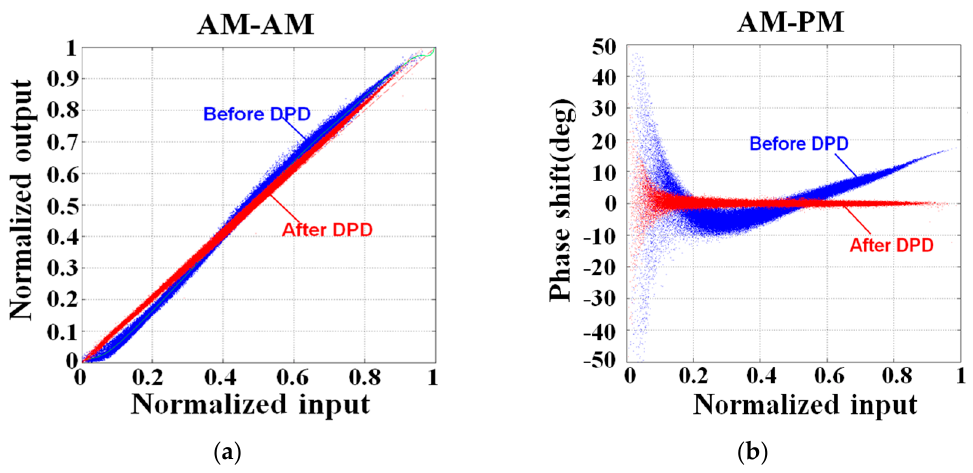
Figure 12. ( a ) AM-AM characteristics of ET PA before and after DPD; ( b ) AM-PM characteristics of ET PA before and after DPD.